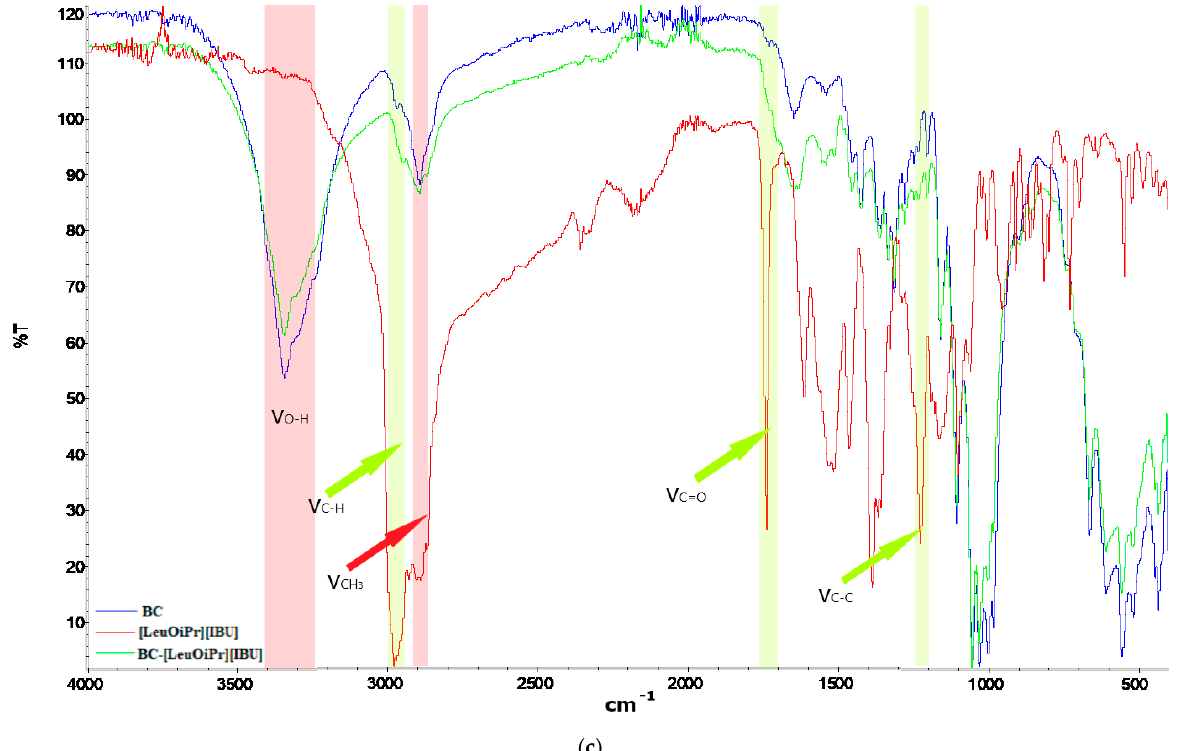
Figure 3. FTIR-ATR spectra of bacterial cellulose and API ( a ) BC (blue), IBU (red) and BC-IBU (green), ( b ) BC (blue), [ValOiPr][IBU] (red), and BC-[ValOiPr][IBU] (green), ( c ) BC (blue), [LeuOiPr][IBU] (red), and BC-[LeuOiPr][IBU] (green). Table 1. Results of mechanical tensile assays obtained BC membranes expressed as Young modulus, elongation at break, and tensile strength. Mean values ± standard deviation, n = 5.